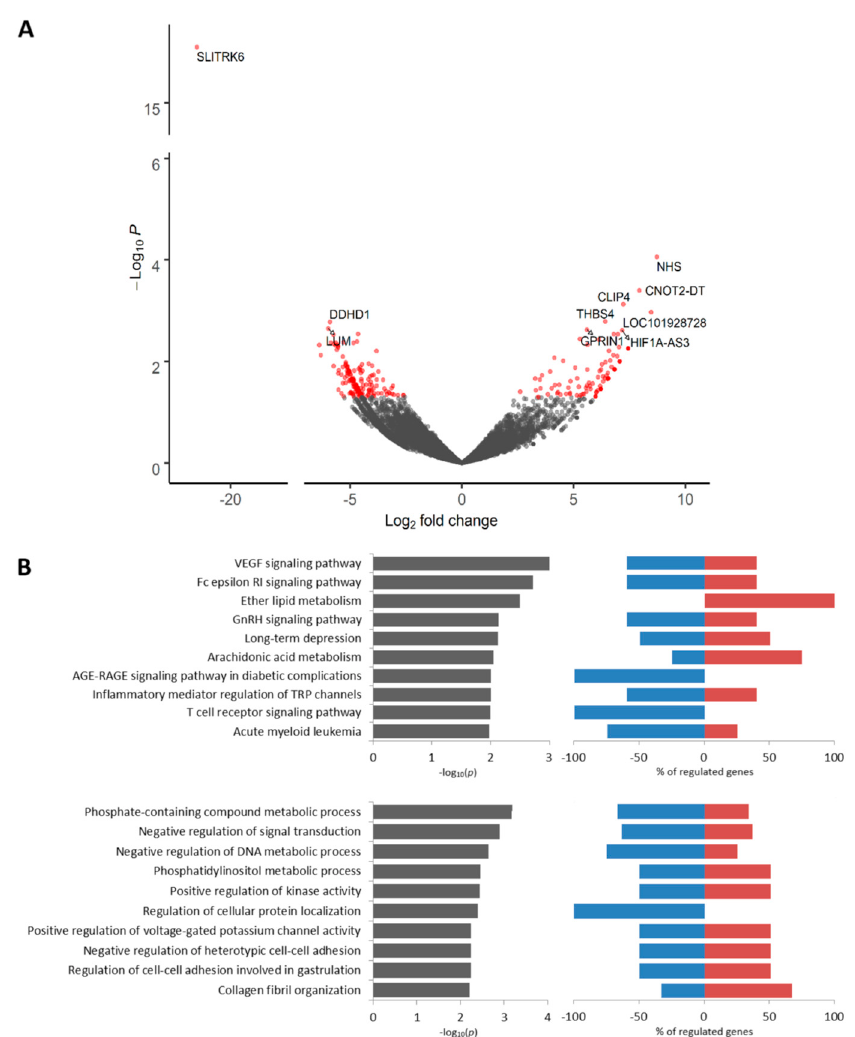
Figure 3. Differential expression analysis of KIF14-positive tumor cells. Volcano plot of TOP 10 up- and downregulated genes ( A ). TOP 10 KEGG signaling pathways and GO biological processes ( B ). Up- and downregulated genes with an unadjusted p -value < 0.05 were used for functional enrichment analysis. The left panel shows –log10p of the perturbation determined from a gene set test, whereas the right panel demonstrates a percentage of genes from corresponding KEGG and GO nodes that are down- and upregulated.